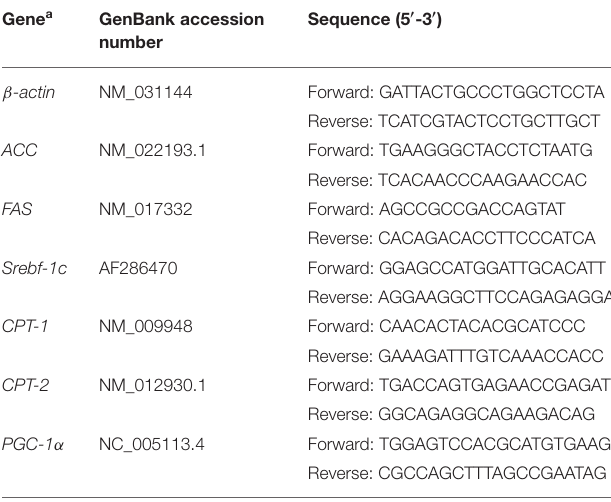
TABLE 1 | Sequences of the oligonucleotide primers used for quantitative real-time PCR. Gene a